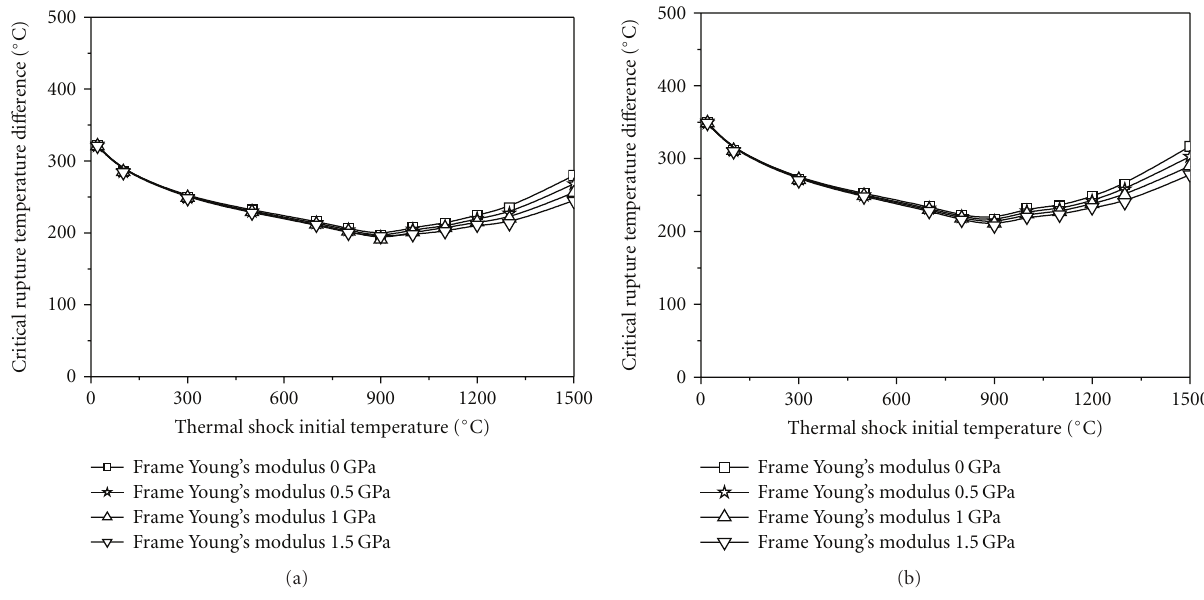
Figure 5: The critical rupture temperature di ff erence versus thermal shock initial temperature for di ff erent frame Young’s modulus with the same heating rate (a) 320 ◦ C · s − 1 and (b) 2000 ◦ C · s − 1 .